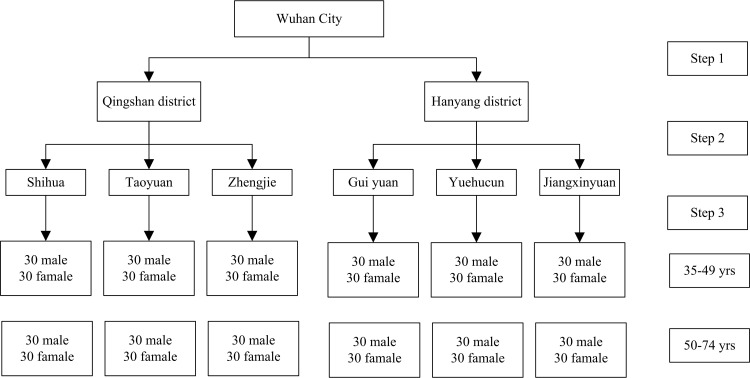
Schematic illustration of multistage sampling.